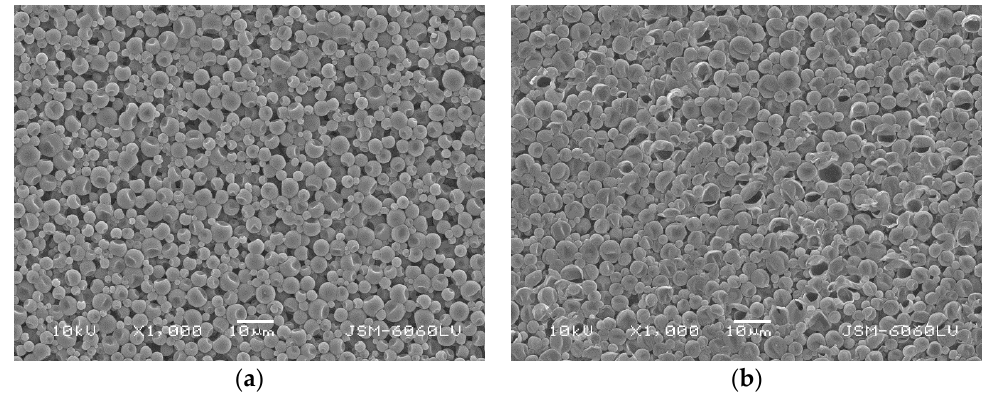
Figure 9. Coated paper with in situ polymerization microcapsules (coating 2 g/m 2 ), after 5 kg weight pulling test: ( a ) SEM 1000×; ( b ) SEM 3300×.